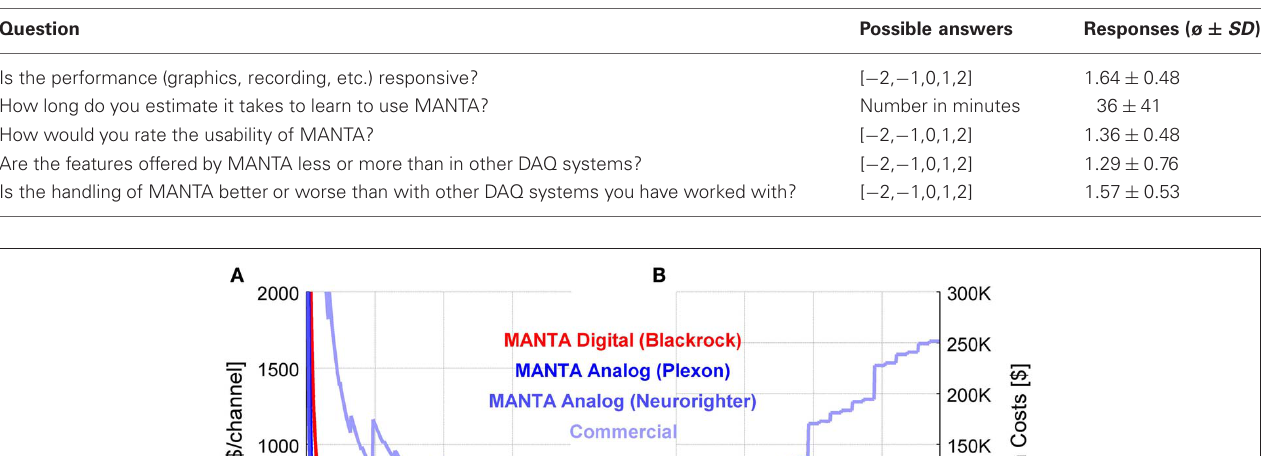
Table 3 | Usability and performance questionnaire ( n = 7).